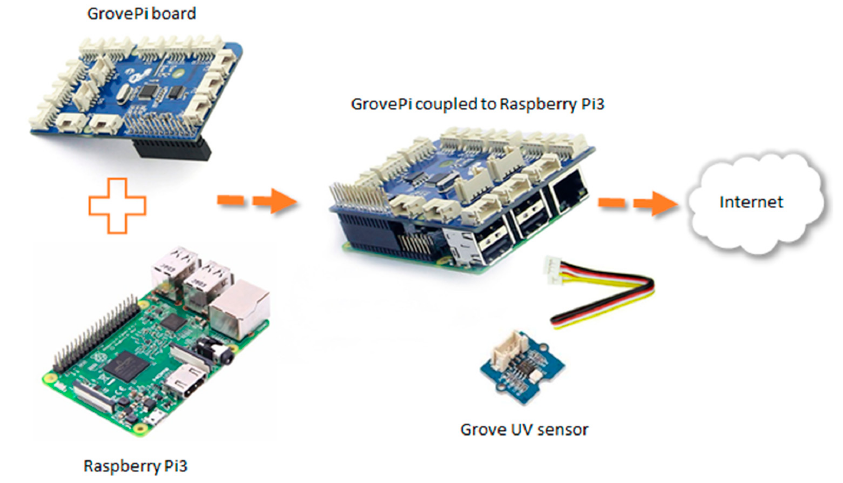
Figure 7. Hardware prototype for UV remote sensor.